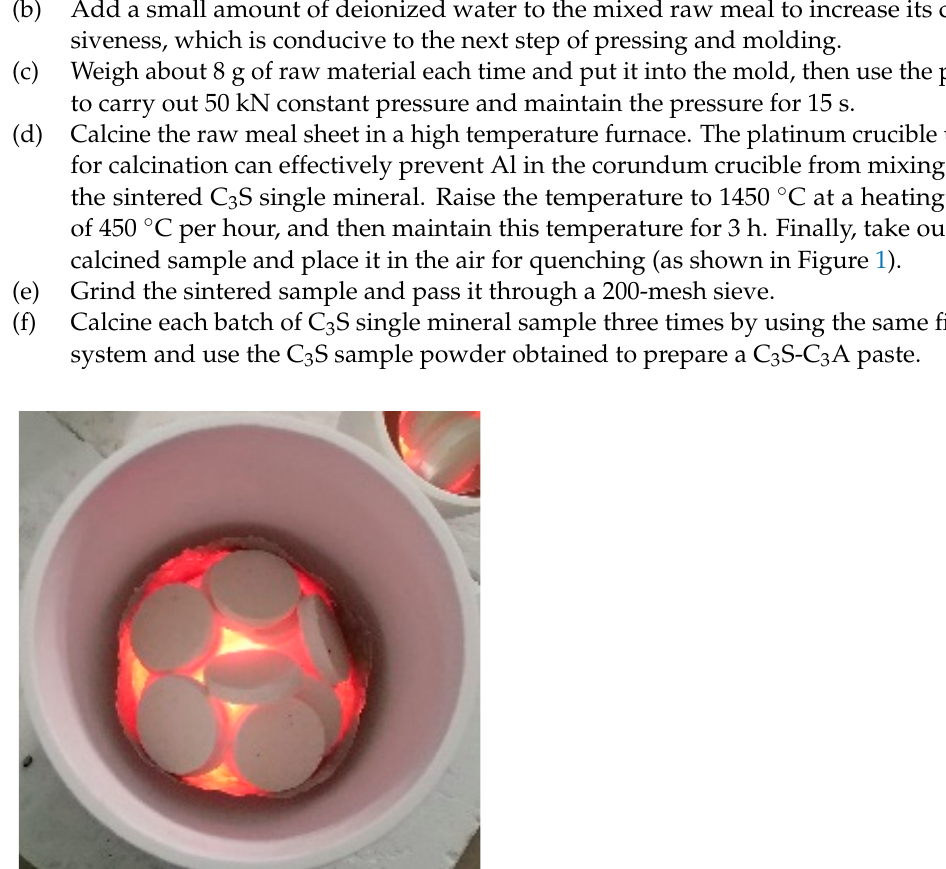
Table 1. Mixture proportion of C 3 A-C 3 S